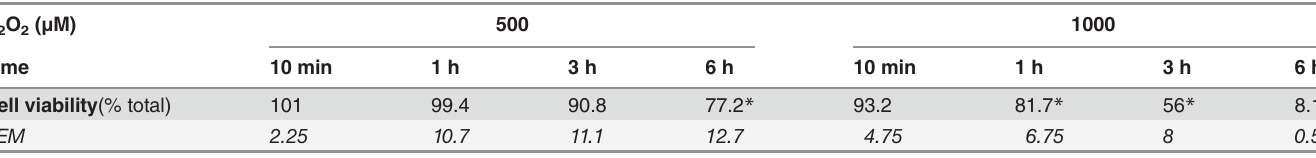
Table 1. Effect of H 2 O 2 on cell